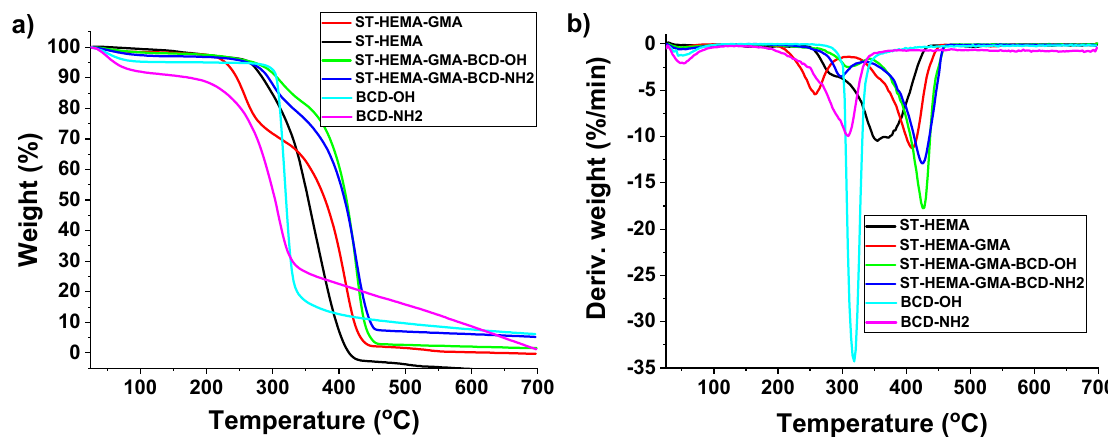
Figure 6. ( a ) TGA curves for BCD-NH 2 , BCD-OH, ST-HEMA-GMA-BCD-NH 2 , ST-HEMA-GMA-BCD-OH, ST-HEMA- GMA, ST-HEMA and ( b ) DTG curves for BCD-NH 2 , BCD-OH, ST-HEMA-GMA-BCD-NH 2 , ST-HEMA-GMA-BCD-OH, ST-HEMA-GMA, ST-HEMA. Table 4. Thermal properties of BCD-NH 2 , BCD-OH, ST-HEMA-GMA-BCD-NH 2 , ST-HEMA-GMA- BCD-OH, ST-HEMA-GMA, ST-HEMA.